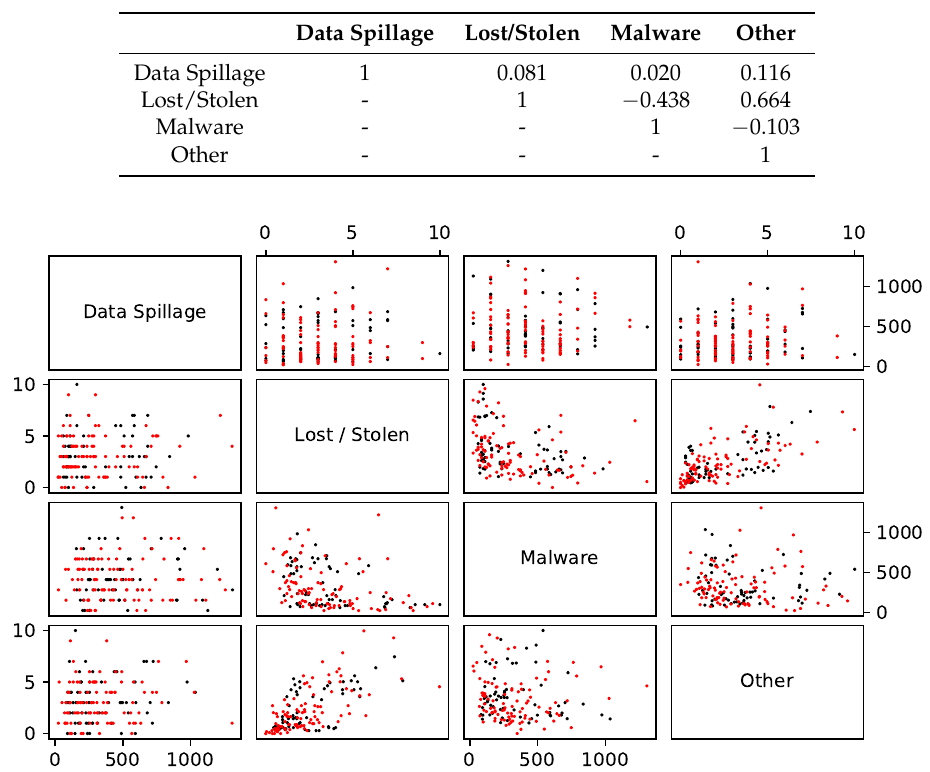
Table 3. The sample correlations between data sets { N i } the total counts for each of the four categories (the blue lines in Figure 2) and finding the sample linear correlation between the different sets of counts.